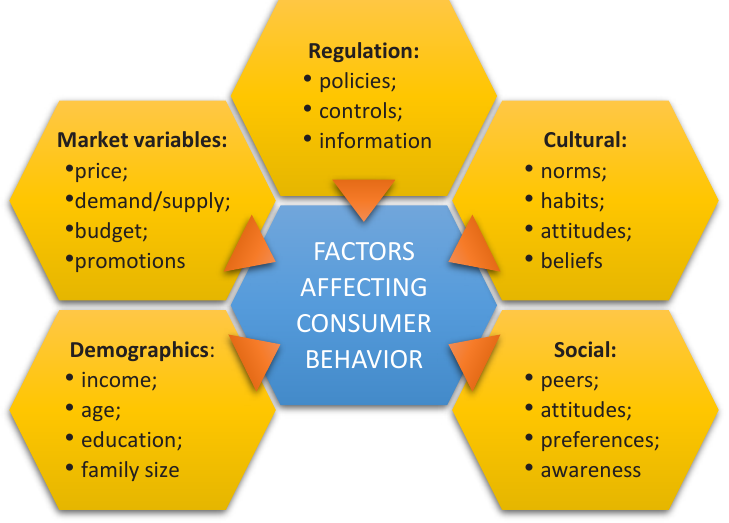
Figure 3. Factors affecting consumer